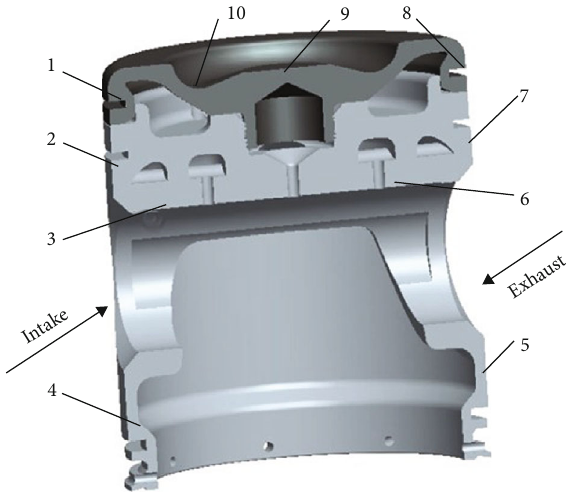
Figure 5: Mounting position of plug on the